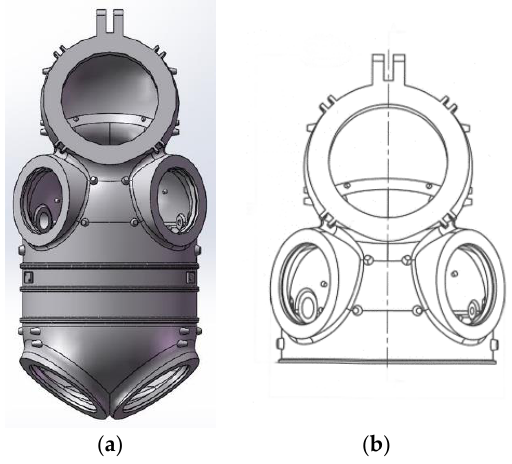
Figure 12. The structure of ADS. ( a ) The front view of ADS. ( b ) The front view of the upper body.